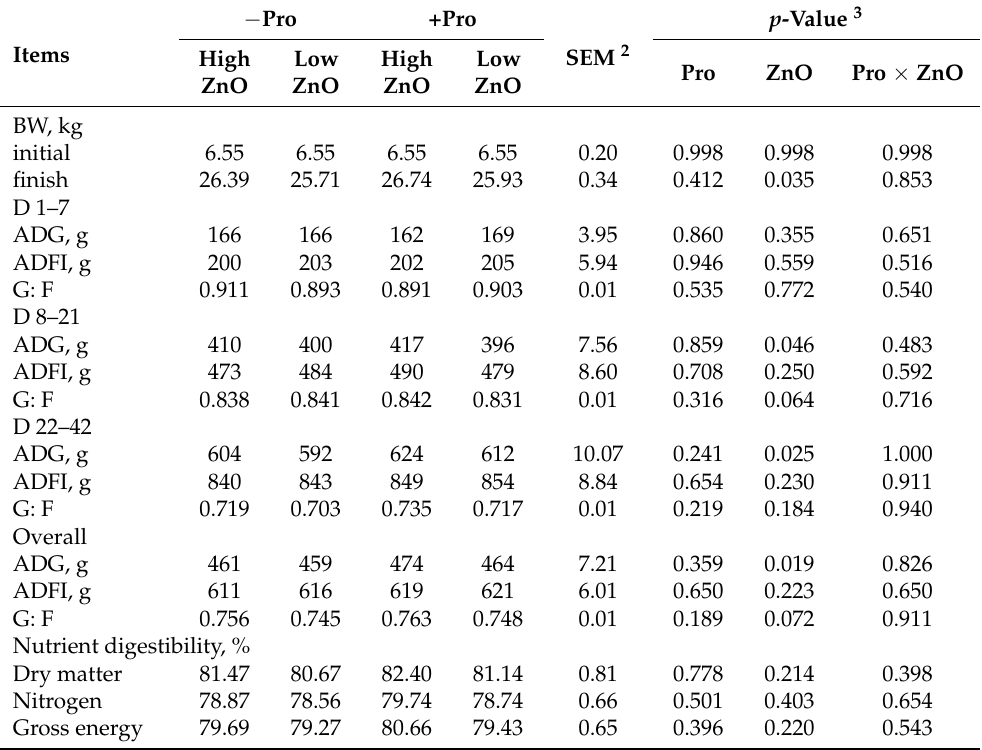
Table 2. Effects of ‘SynerZymeF10’ supplementation in ZnO diets on growth performance and nutrient digestibility in weaning pigs 1 .